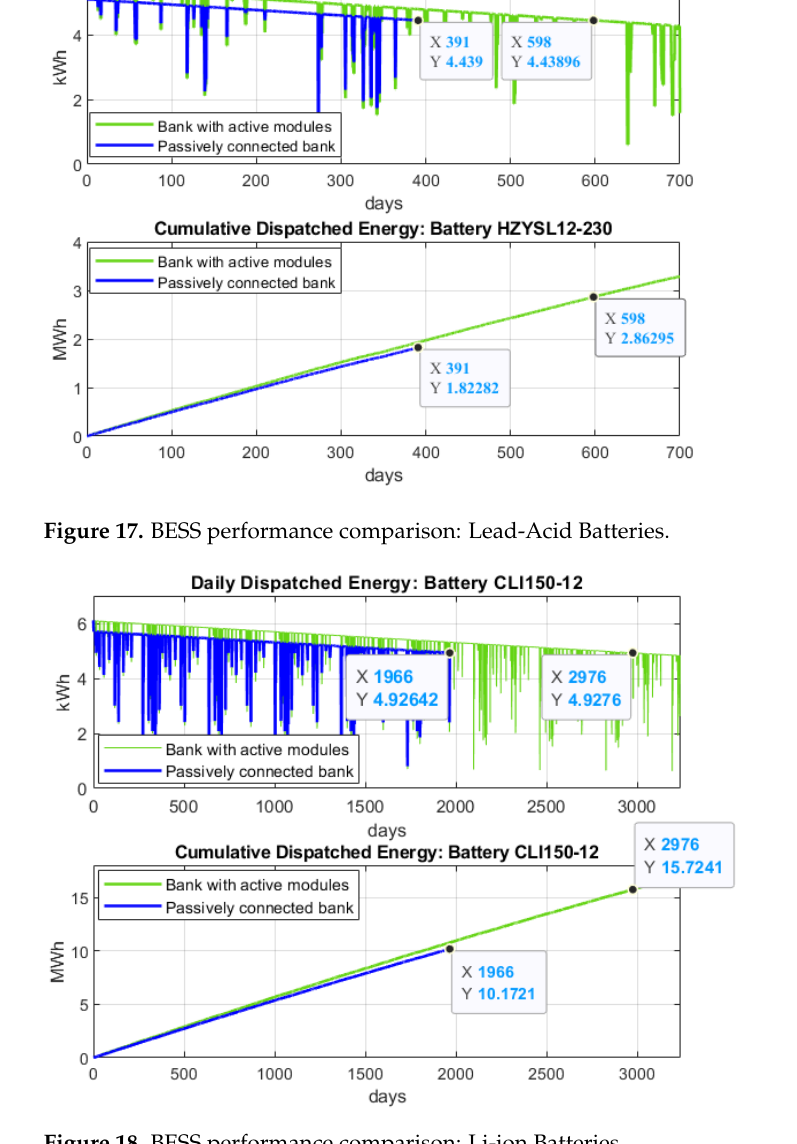
Figure 18. BESS performance comparison: Li-ion Batteries. Table 7. Summary of the Achieved Benefits for the ESS Using the Proposed